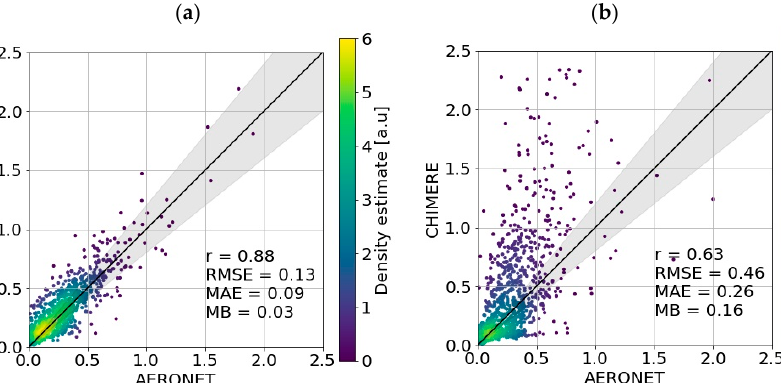
Figure 2. Scatter plot of 966 collocated data points comparing the AOD at 550 nm measured by 8 AERONET sun photometers for the year 2021 with ( a ) MODIS satellite observations and ( b ) simu- lated AODs by the CHIMERE chemistry transport model. The black line is the y = x line with the gray shaded areas representing the ± 20% interval of its slope.